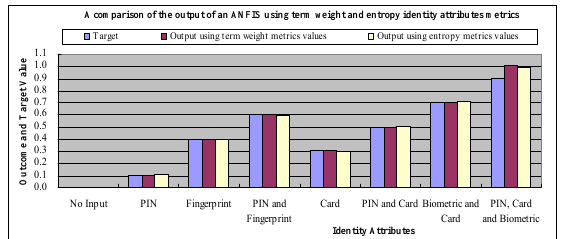
Fig. 7. A comparison of the information fusion techniques output for an artificial neural network, fuzzy inference system and adaptive neural-fuzzy inference system using entropy identity attributes metrics values.